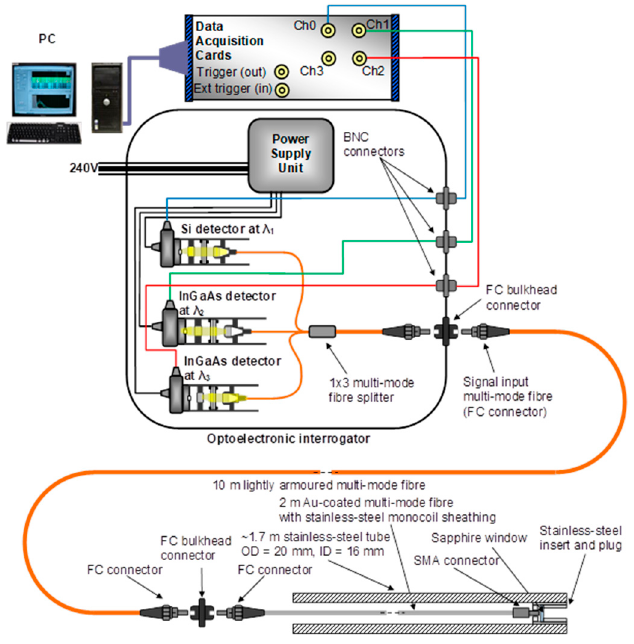
Figure 1. Schematic of the system.